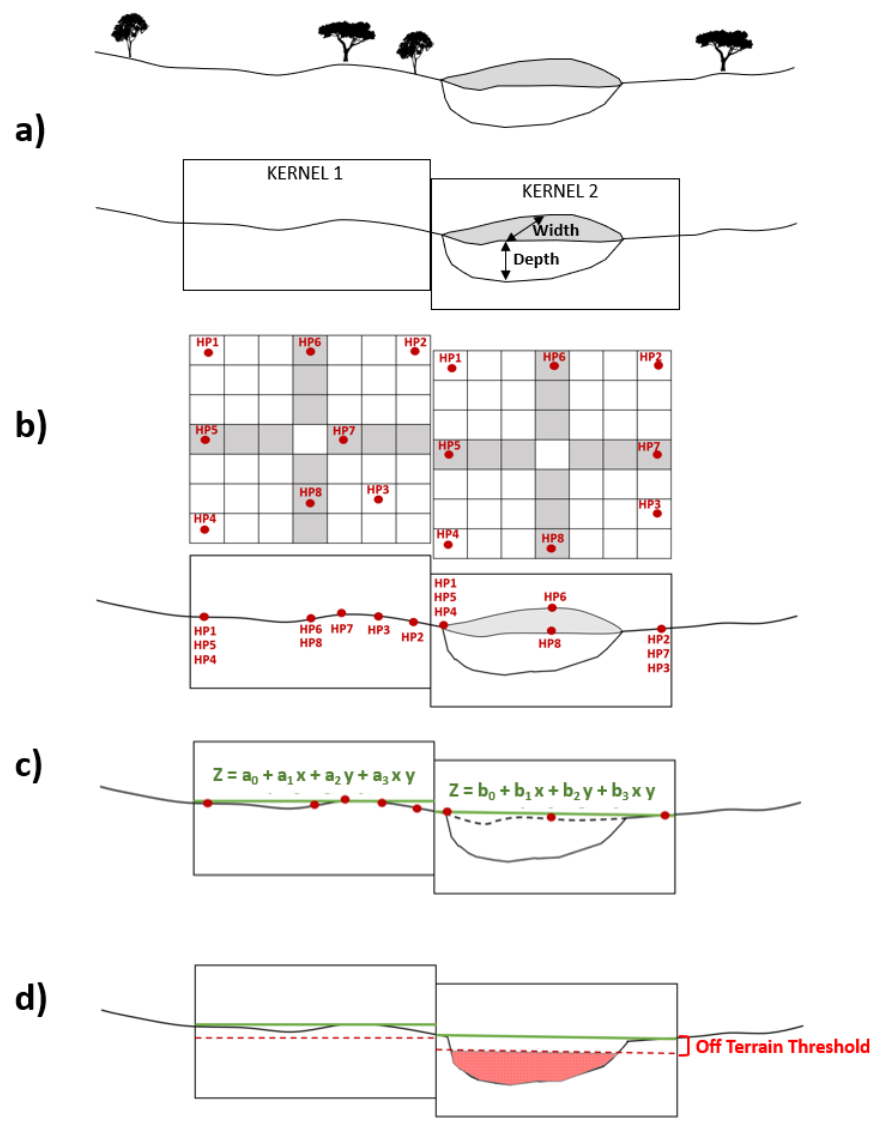
Figure 4. Simplified schema of the different steps of the SMPF algorithm applied to gully detection: ( a ) A moving kernel iterates over the Digital Elevation Model (DEM); ( b ) for each kernel, eight sub-areas are defined and, for each sub-area, the highest pixel in altitude is detected; and, ( c ) used as input points to adjust an bilinear surface that ( d ) defines the off terrain volumes as those remaining below, considering a tolerance (off-terrain threshold).